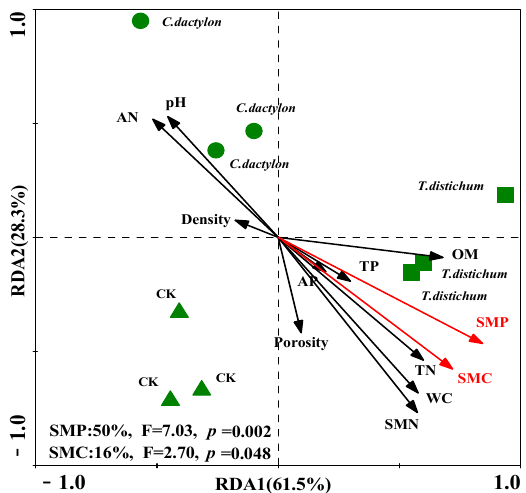
Figure 3. The redundancy analysis (RDA) used to identify the relationship between the soil variables and enzyme activity. The arrows indicate the soil parameters, and the red one indicates significant impacts of the soil parameters on soil enzyme activities ( p < 0.05). The explained proportion of variability by Monte Carlo permutation is shown at the bottom.